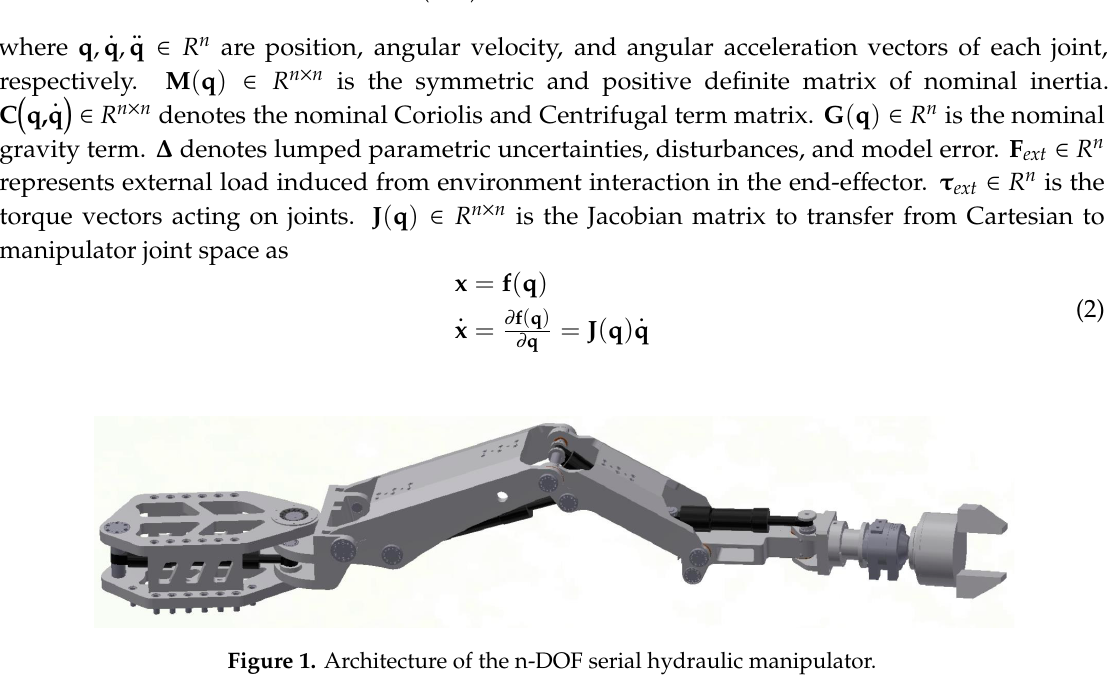
Figure 2. Working principle of electro-hydraulic actuators: ( a ) rotary type, ( b ) cylinder type.